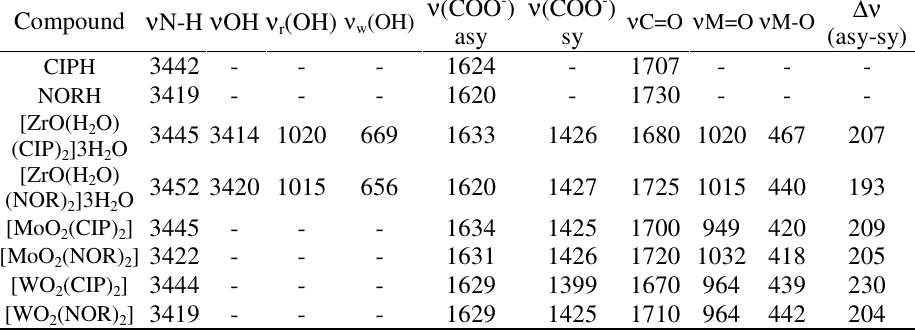
Table 2. Important FTIR spectra of CIPH and NORH and their